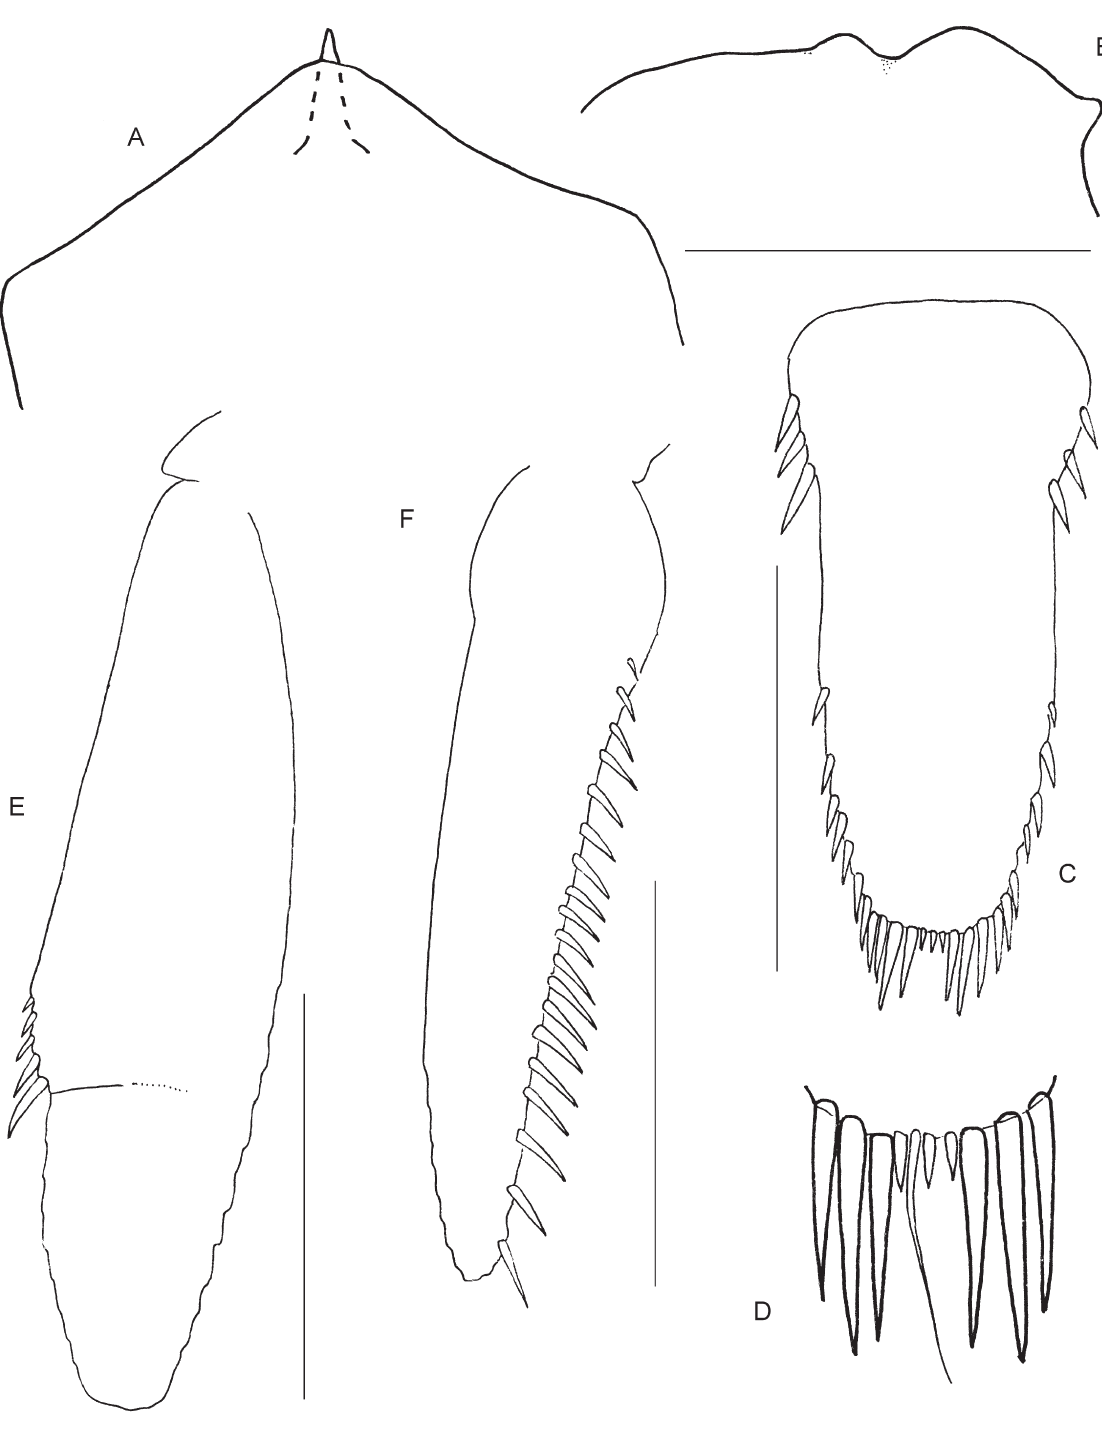
Fig. 29. Siriella vincenti W.M. Tattersall, 1927, syntype, ♀, length 7.5 mm, Gulf of St. Vincent, South Australia. A . Anterodorsal margin of carapace and subrostral process. B . Dorsal part of carapace, lateral view. C . Telson. D . Apical part of telson, dorsal view. E . Uropodal exopod, ventral view. F . Uropodal endopod, ventral view. Scale bars: A–C, E–F = 0.5 mm; D = 0.25